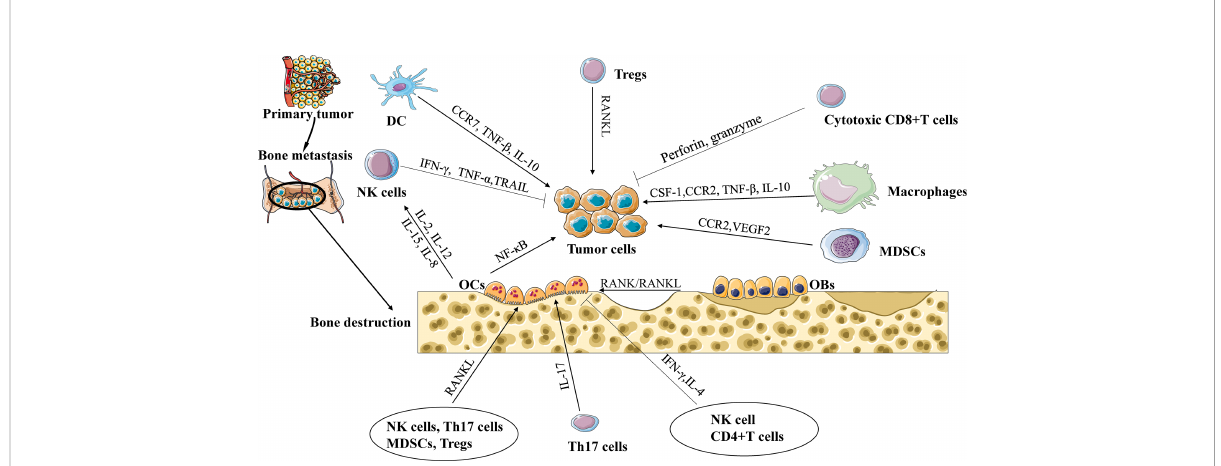
FIGURE 1 The interaction of immune cells, tumor cells, and osteocytes during bone metastasis. Cytotoxic CD8+ T cells release TNF- a and IFN- g to eliminate tumor cells. Regulatory T cells (Tregs) promote tumor cell to bone metastasis through the RANK/RANKL axis. Tumor-associated macrophages (TAMs) promote tumor cell to bone metastasis through CCL2/CCR2 or CSF-1/ CSF-1R signaling. Natural killer cells (NK cells) can destroy tumor cells by secreting TNF- a and tumor necrosis factor-related apoptosis-inducing ligand. Dendritic cells (DCs) and TAMs suppress the cytotoxic capacity of CD8+ T cells via TGF- b , and interleukin-10 (IL-10) to promote tumor progression. Myeloid-derived suppressor cells (MDSCs) release chemokines, including vascular endothelial growth factor (VEGF) and CCL2/CCR2 signaling, to promote cancer progression and bone metastasis. IL-17 can also increase bone metastases, while IFN- g and IL-4 secreted from Th1 and Th2 cells, respectively, can inhibit osteoclast formation and limit bone metastases. NK cells and CD4+ T cells support or repress the production of OCs controlled by the release of TNF- a or IFN- g